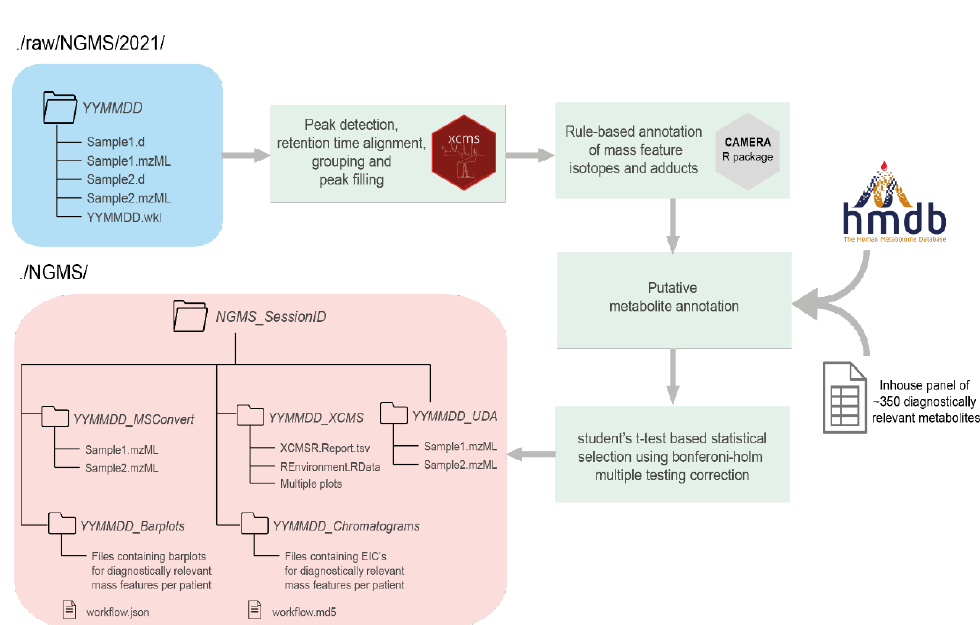
Figure 2. Flow chart of the steps performed by the Workflow engine once a new session is initiated by the user for data processing using the Workflow starter. Input data are colored in blue, the various data processing steps in the pipeline are colored in green, and output data are colored in red. Arrows identify the path of the workflow at each step of the pipeline. There are multiple external tools used XCMS R package [14], CAMERA R package [15] and the Human Metabolome Database (HMDB)